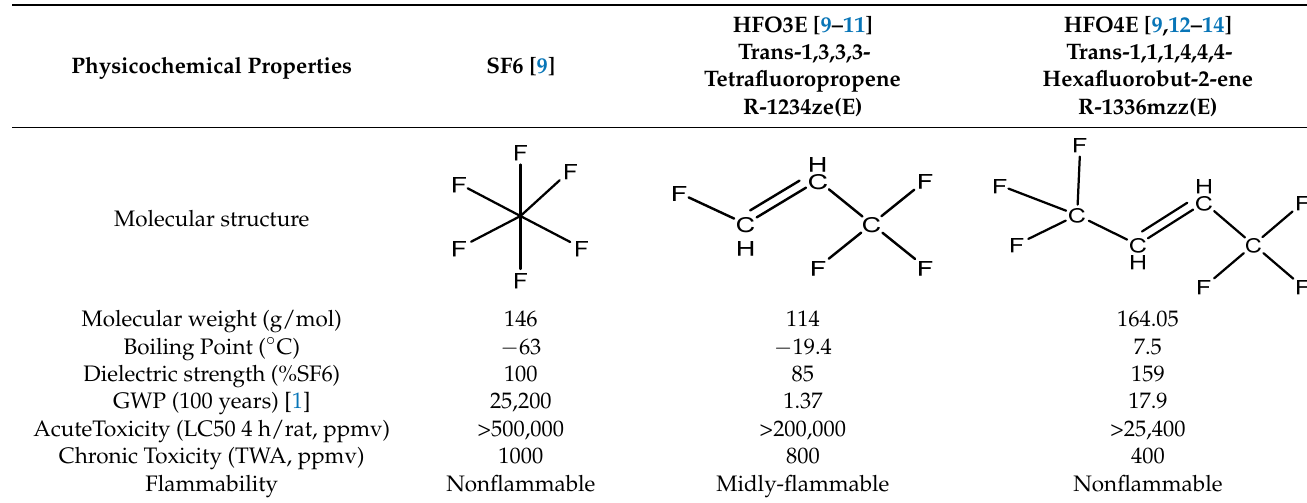
Table 1. Physicochemical properties of HFO4E and HFO3E in comparison with SF6.